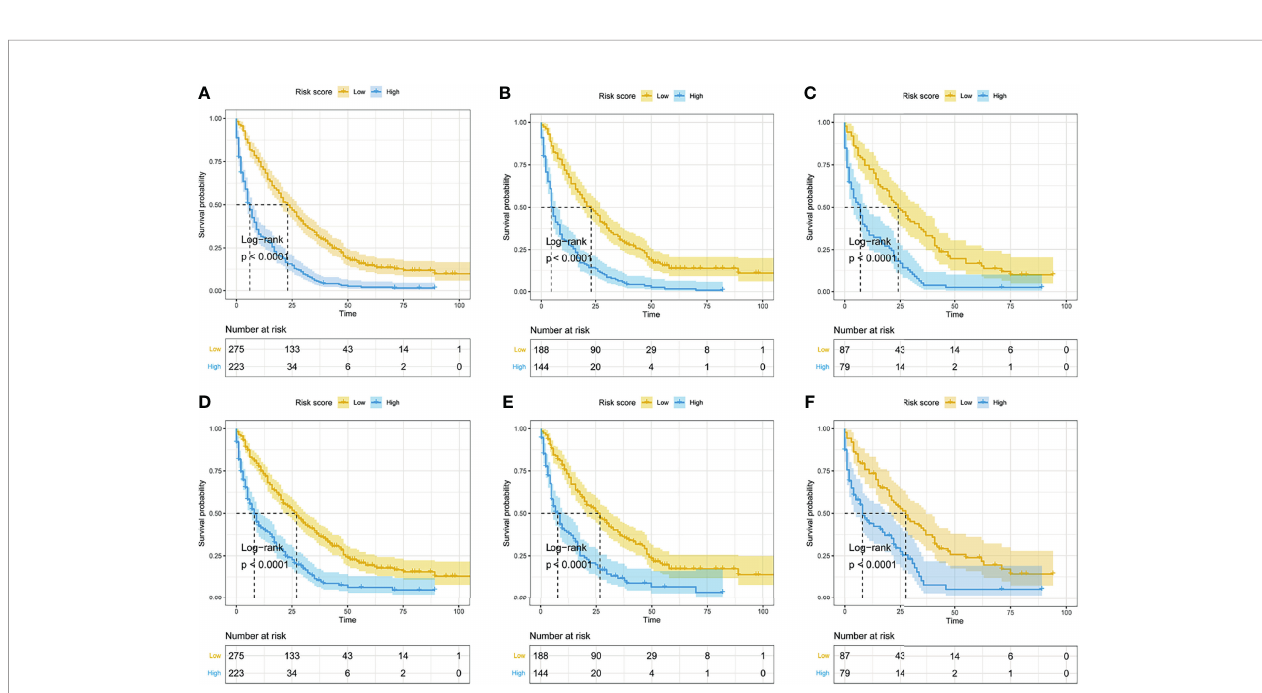
FIGURE 11 | The Kaplan – Meier curves for OS and CSS based on risk score grouping from the nomogram. According to the median of risk scores in the entire cohort, the whole cohort was divided into two subgroups (low-risk group and high-risk group). The Kaplan – Meier curves for OS (A) and CSS (D) in the whole cohort. The Kaplan – Meier curves for OS (B) and CSS (E) in the training set. The Kaplan – Meier curves for OS (C) and CSS (F) in the validation